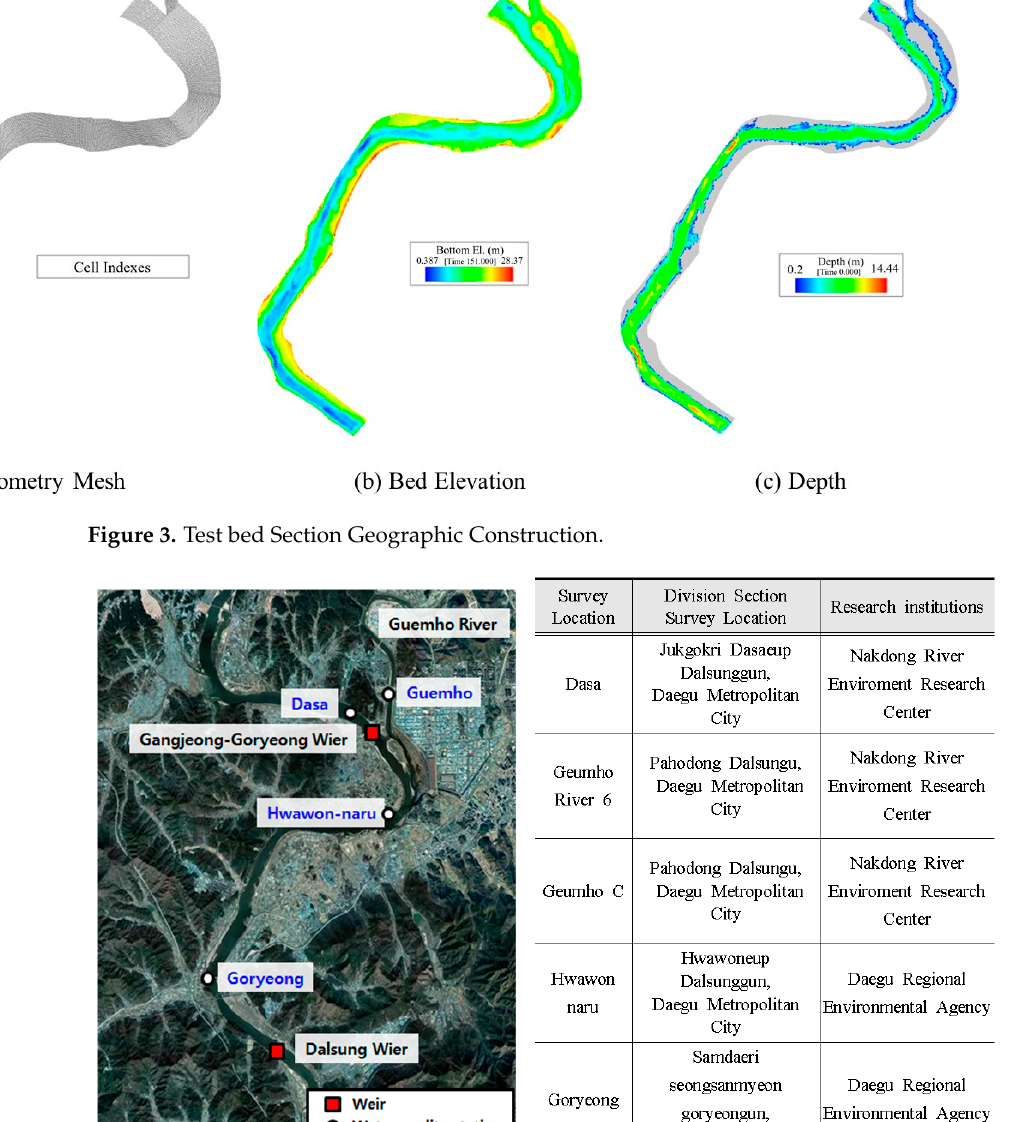
Figure 3. Test bed Section Geographic Construction.